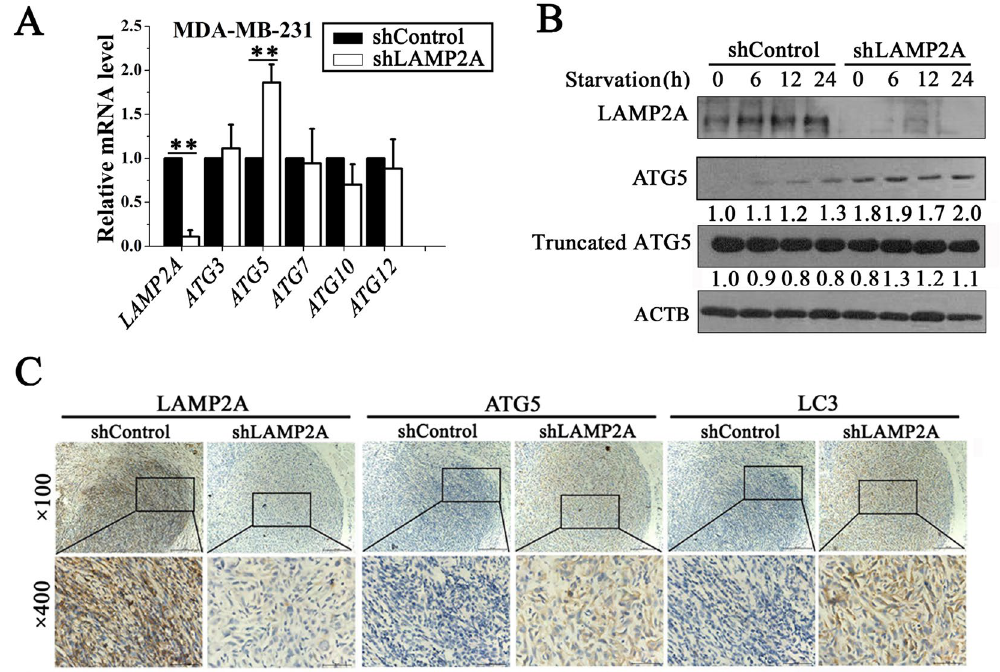
Figure 5. CMA-mediated inhibition of macroautophagy is ATG5 dependent. ( A ) qRT-PCR analysis of the ATG5-dependent macroautophagy gene expression levels in shLAMP2A or shControl MDA-MB-231 cells (left) (n = 3; Student’s t test, ** P < 0.01, statistical comparison between the two marked treatment groups). ( B ) shLAMP2A or shControl MDA-MB-231 cells were starved and harvested at the indicated timepoints for immunoblotting of ATG5 and truncated ATG5. The numbers underneath each lane represent the densitometric quantification of the detected protein after normalizing to β -actin. ( C ) LAMP2A, ATG5 and LC3 levels in the subcutaneous tumor tissues of shLAMP2A or shControl MDA-MB-231-implanted mice were measured by